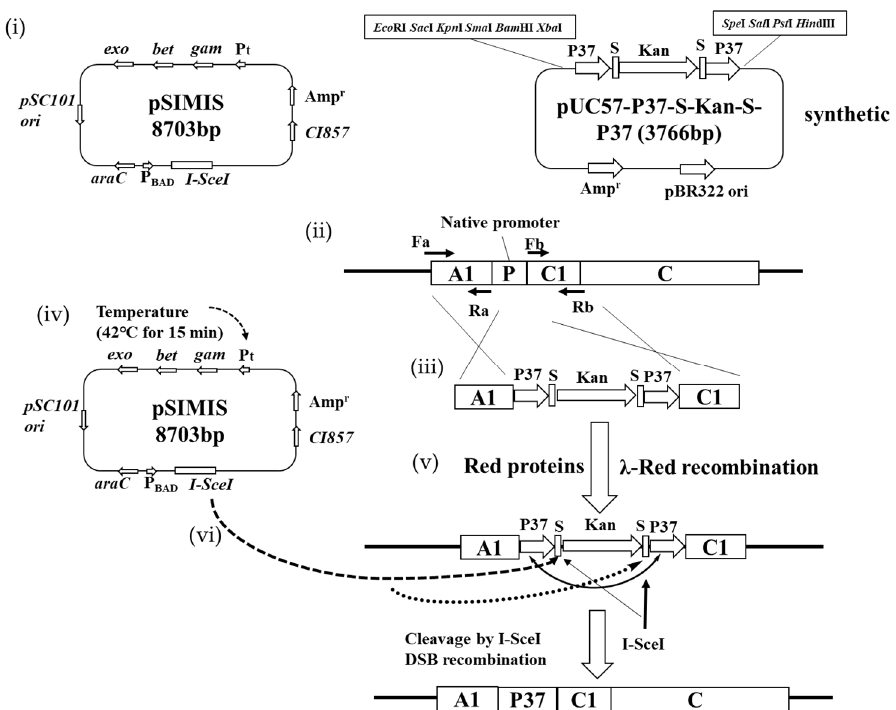
Figure 4. Description of rapid markerless promoter replacement with pSIMIS. (i) Plasmids used for λ -Red recombination and I-SceI cleavage. (ii) To replace the native promoter of target gene C, the left and right homologous arms were separately amplified by PCR using primers F a /R a or F b /R b , and then cloned into the left or right MCS of pUC57-P37-S-Kan-S-P37. (iii) A linear DNA cassette containing the left arm A1, P37-S-Kan-S-P37 and right arm C1 was obtained by restriction of enzymatical digestion or PCR. (iv) The linear DNA cassettes were electroported into E. coli cells containing pSIMIS. (v) With help of the λ -Red proteins, the cassette could replace a target genomic segment after temperature induction. (vi) The I-SceI endonuclease in pSIMIS was induced by 10 mM arabinose to remove the introduced selection marker, and the chromosome was cleaved at the I-SceI recognition site (S). Then, the double-stranded break (DSB)-mediated intramolecular recombination between the two P37 led to the removal of the selection marker, yielding a clean, markerless promoter replacement